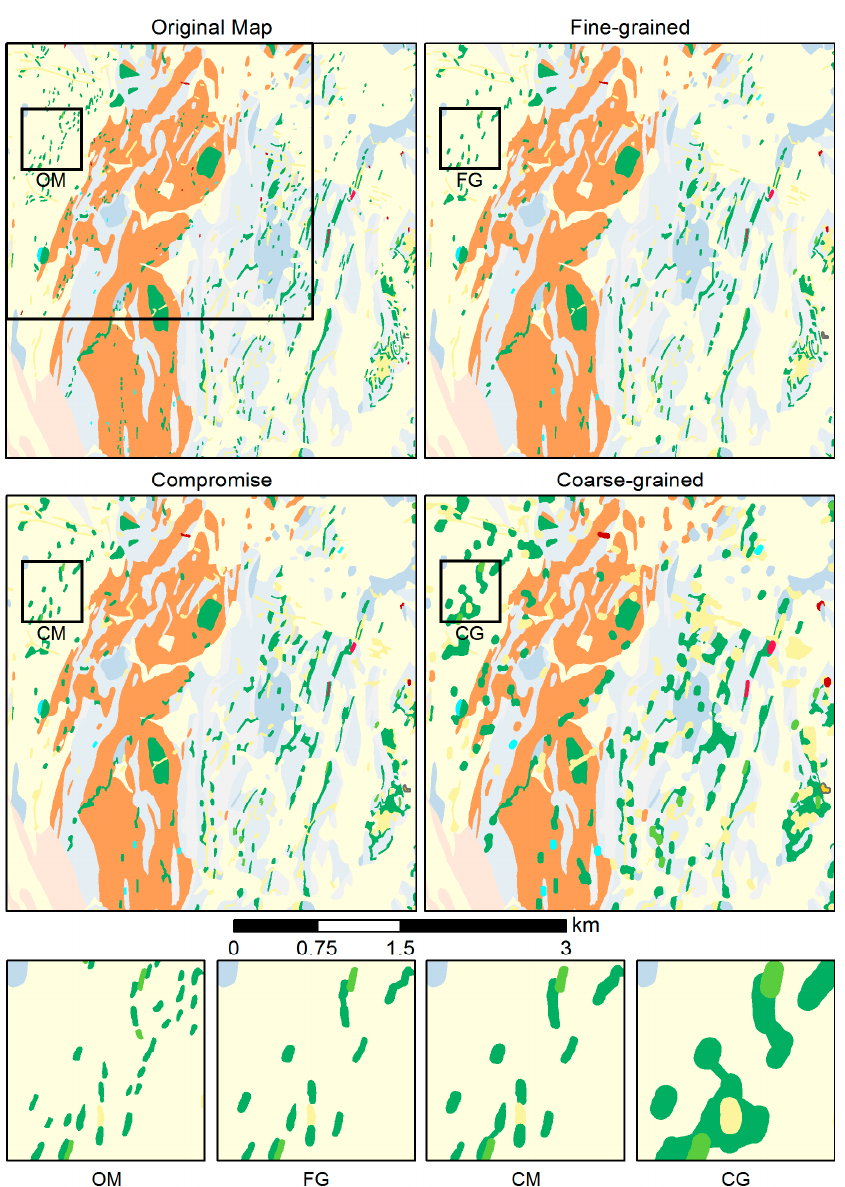
Figure 15. Effect of varying the thresholds for the size constraints using the three sets of goal values from Table 4. The large black rectangle in the original map denotes the map window used in Figure 16. The display scale is 1:50,000. The bottom row depicts four magnified examples: OM (original map), FG (fine-grained), CM (Compromise), CG (coarse-grained).